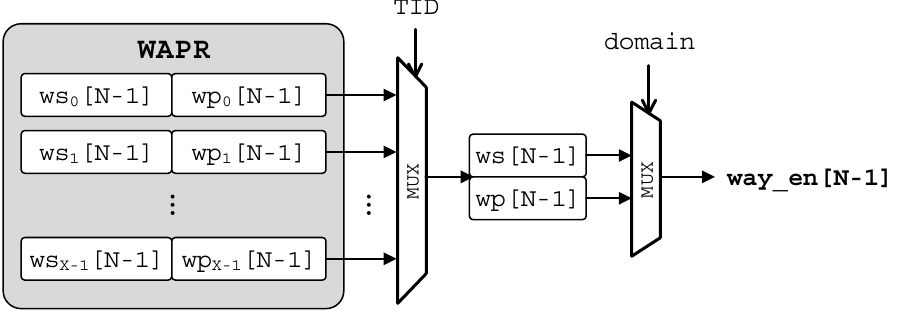
Figure 6. Way access permission registers and way enable logic.